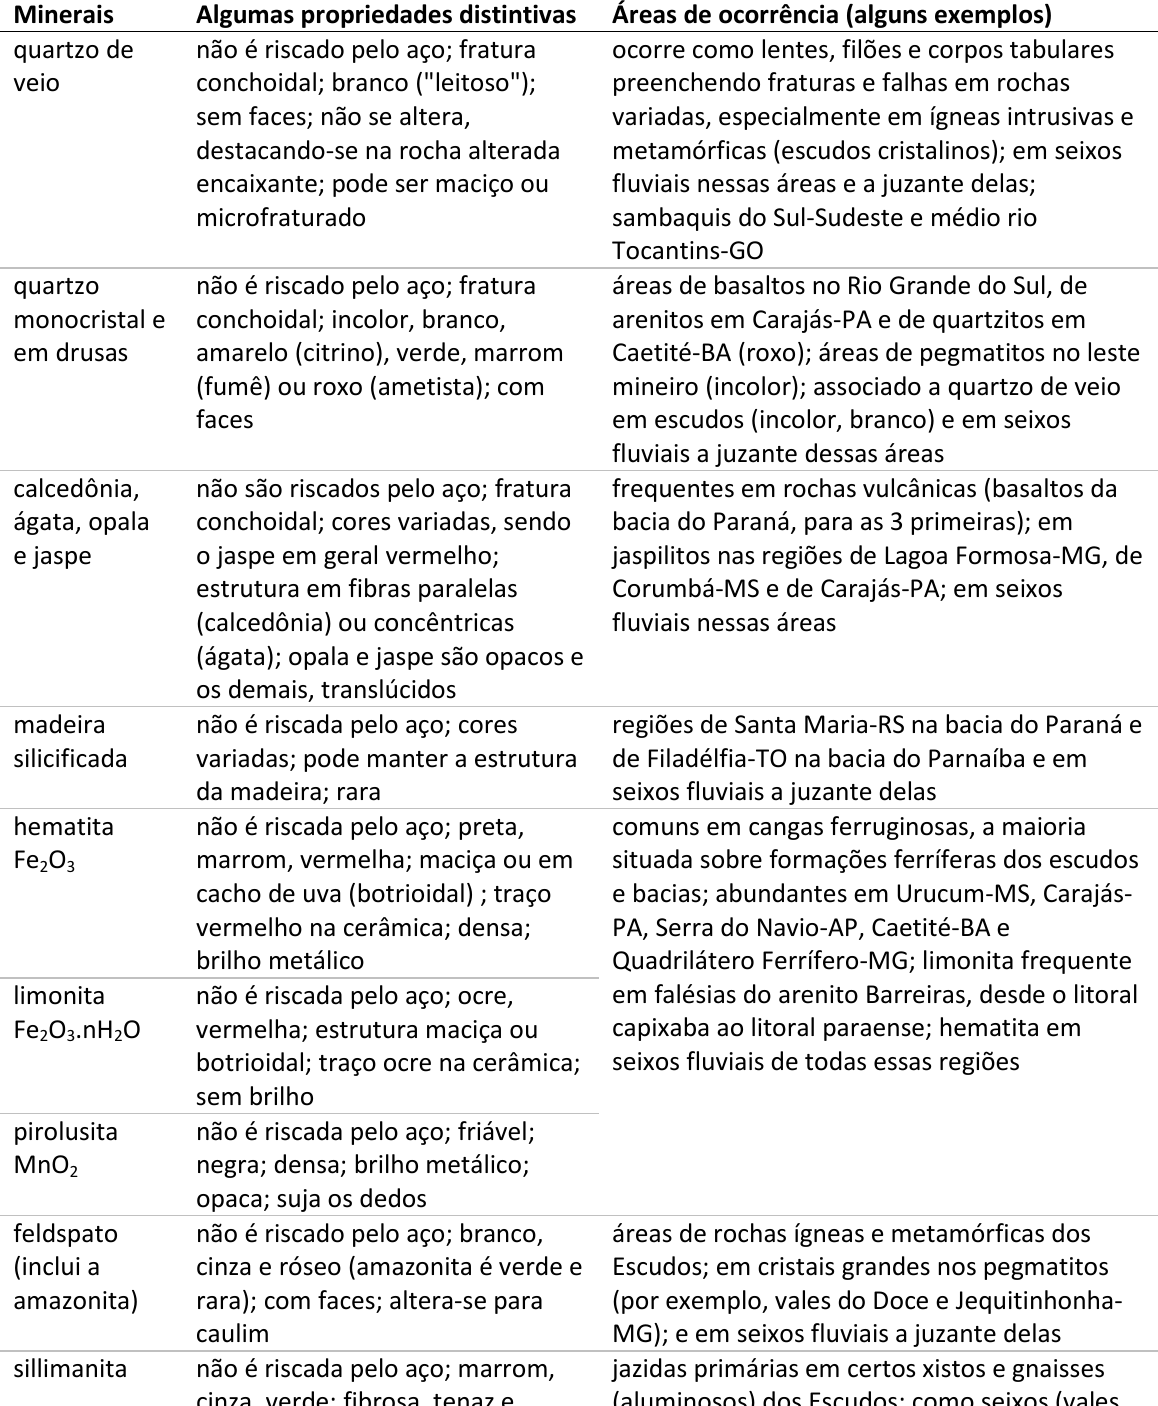
Table 3. General criteria for field distinction of the main Brazilian minerals, many of them used by human groups in the archaeological past. Main sources: Akhavan (2010), Dana & Hurlbut (1974), Hasui et al.